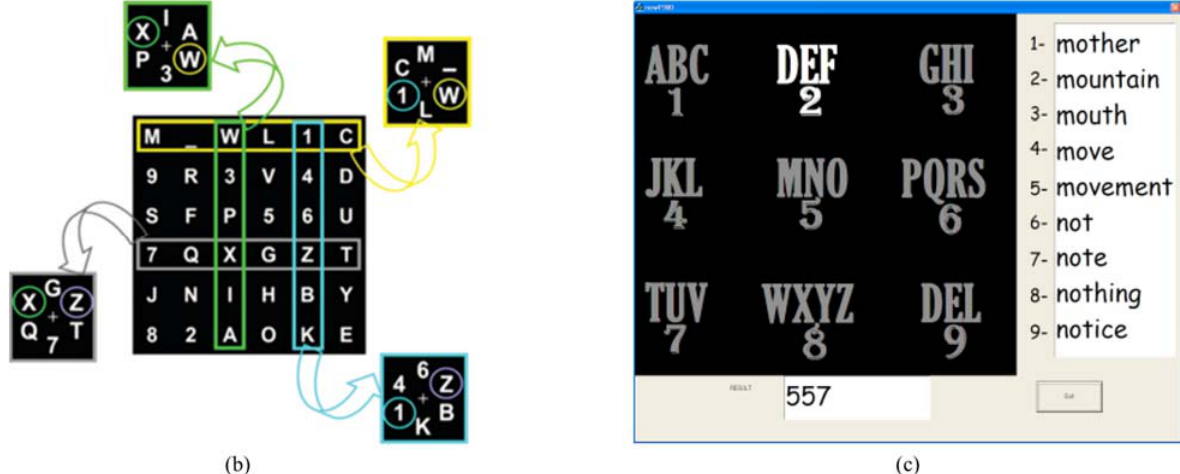
Figure 3. ( a ) The rapid serial visual presentation approach developed by Acqualagna et al. (2010) [45] (image adapted); ( b ) Grouped presentation of Aloise et al. (2012) [46]; ( c ) The T9 paradigm of Akram et al. (2014)